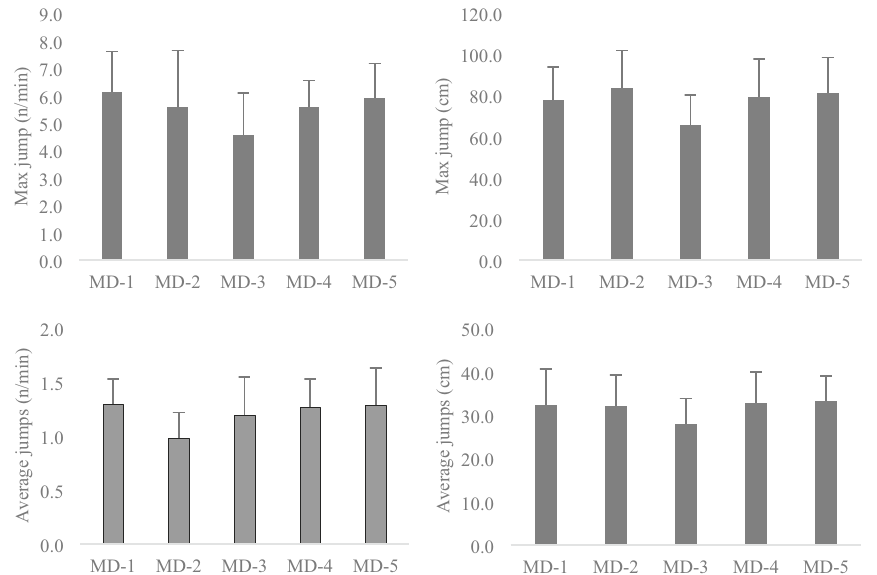
Figure 1. Mean and standard deviation (average of the group) of maximum values recorded for the maximal jump height, maximal jump value, average maximal jump height, maximum number of jumps per minute, and average number of jumps per minute split by training